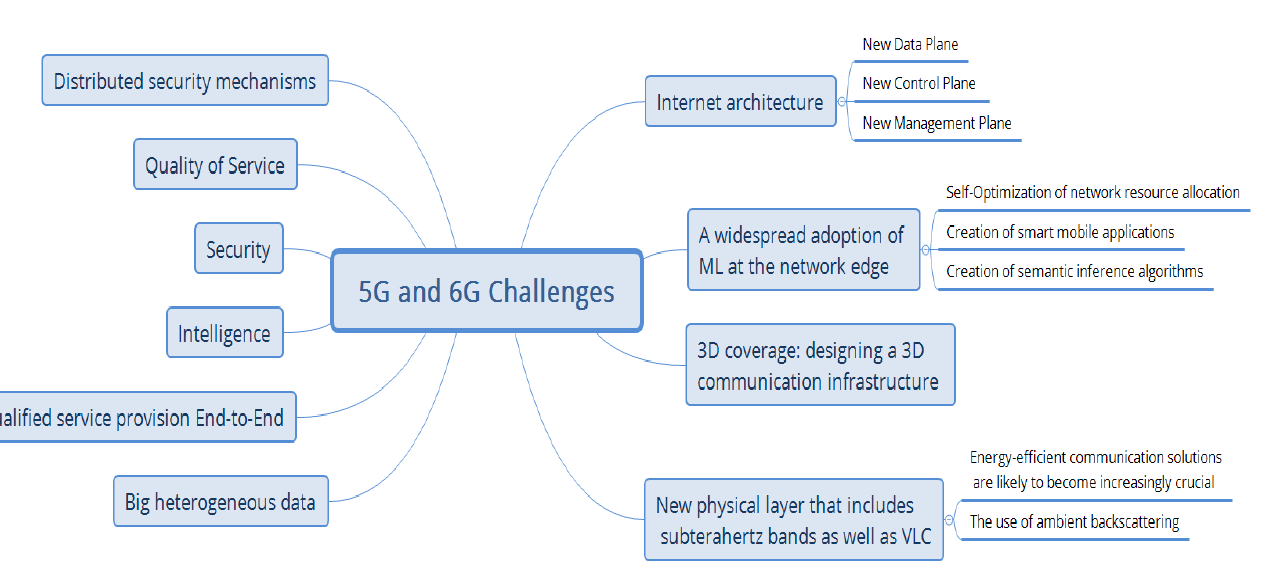
Figure 6. 5G and 6G